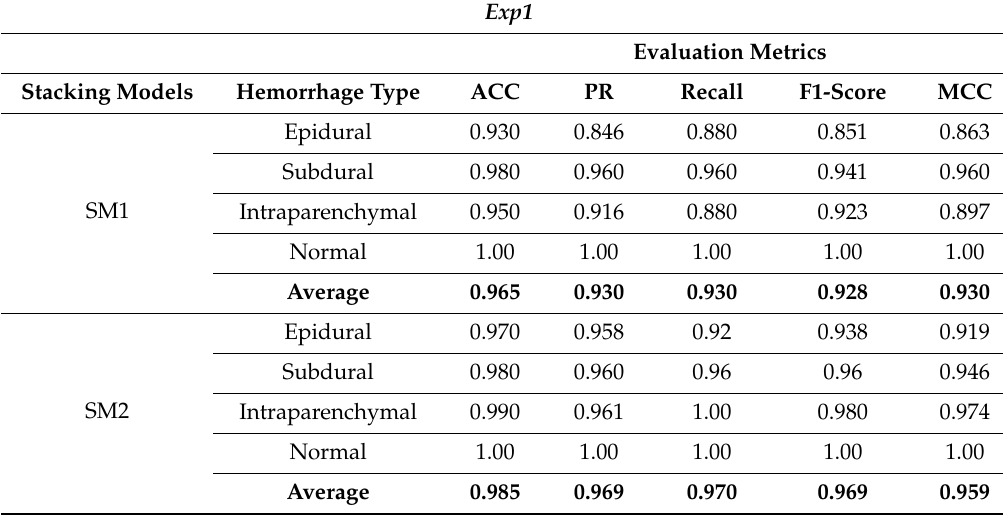
Table A2. Class-wise and average values of performance metrics of stacking models on CT scan dataset for three di ff erent experiments, Exp1, Exp2 and